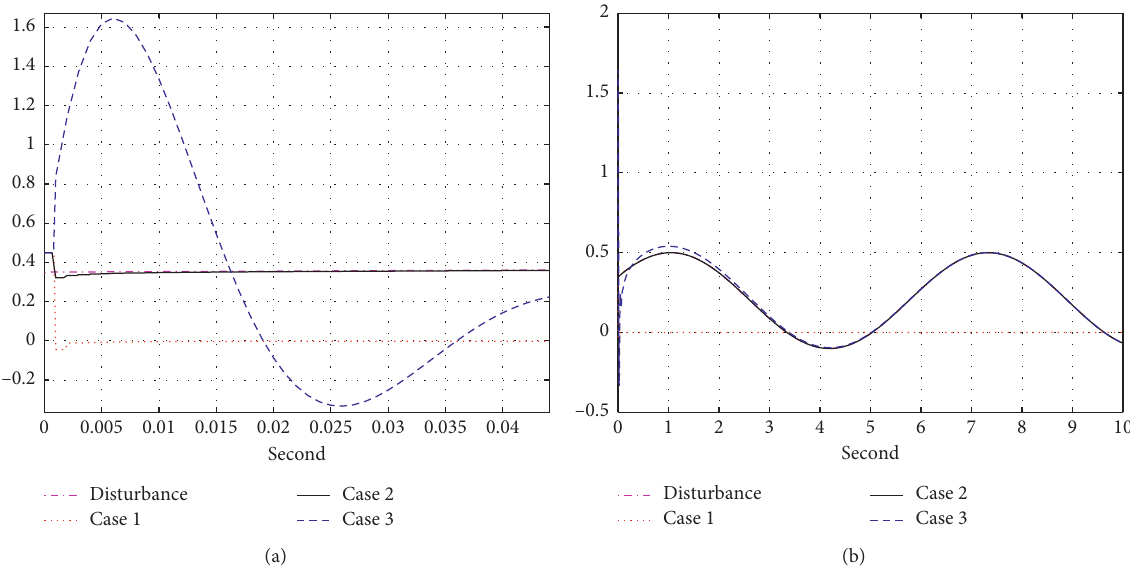
Figure 2: Left wheel disturbance and its estimation for cases. (a) First short interval. (b) Full simulation time.